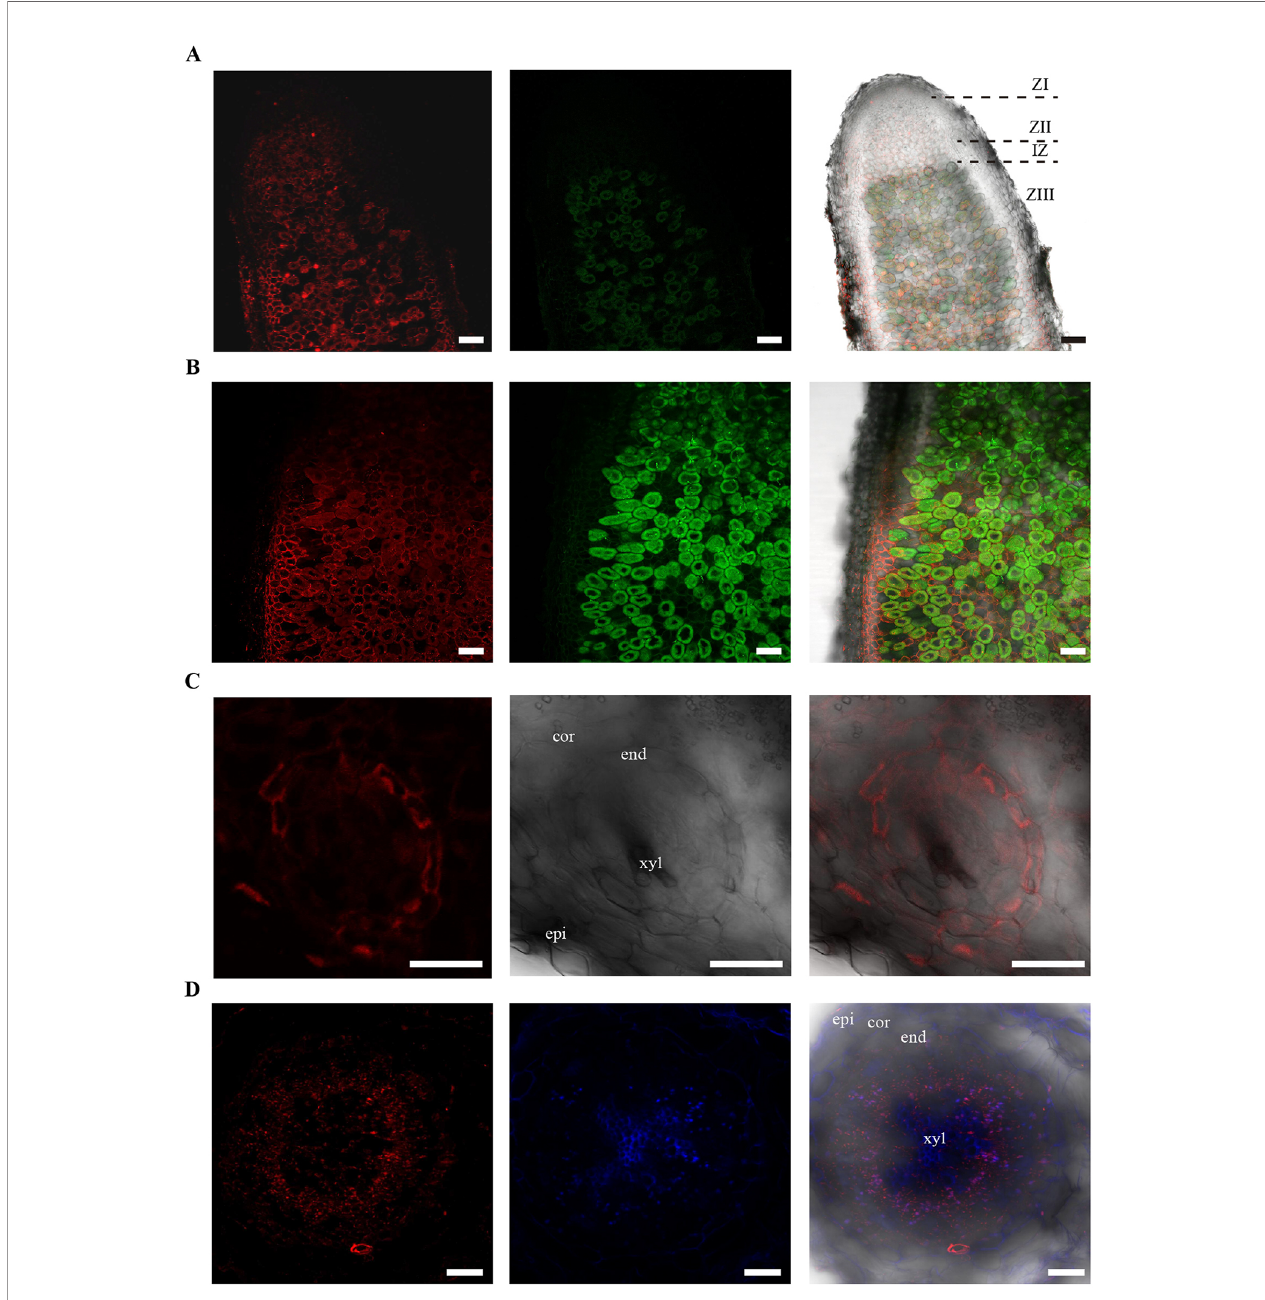
FIGURE 5 | MtNAS2 is located in the nodule core cells, in the endodermis of the nodule vessels, and in cells surrounding the xylem in the root vasculature. (A) Longitudinal section of a 28 dpi M. truncatula nodule expressing MtNAS2-HA under its own promoter (n = 30 sections from 10 to 20 plants). The three C- terminal HA epitopes were detected using an Alexa594-conjugated antibody (red, left panel). Transformed plants were inoculated with a GFP-expressing Sinorhizobium meliloti (green, middle panel). Both images were overlaid with the transillumination image (right panel). ZI indicates zone I; ZII, zone II; IZ, interzone; and ZIII, zone III. Bars = 100 m m. (B) Detail of the zone III of a 28 dpi M. truncatula nodule expressing MtNAS2-HA under its own promoter. Left panel corresponds to the Alexa594 signal used to detect the HA-tag, middle panel corresponds to the GFP channel showing S. meliloti , and the two were overlaid with the bright fi eld channel in the right panel (n = 30 sections from 10 to 20 plants). Bars = 50 m m (C) Cross section of a nodule vessel from a 28 dpi M. truncatula nodule expressing MtNAS2- HA under its own promoter. Left panel corresponds to the Alexa594 signal used to detect the HA-tag, middle panel corresponds to the bright fi eld channel, and the two were overlaid in the right panel (n = 30 sections from 10 to 20 plants). epi indicates nodule epidermis; cor, nodule cortex; end, nodule vascular endodermis; and xyl, nodule vascular xylem. Bars = 50 m m. (D) Cross section from a 28 dpi M. truncatula root expressing MtNAS2-HA under its own promoter. Left panel corresponds to the Alexa594 signal used to detect the HA-tag, middle panel corresponds to auto fl uorescence signal of xylem, and the two were overlaid with the bright fi eld channel in the right panel (n = 30 sections from 10 to 20 plants). epi indicates root epidermis; cor, root cortex; end, root endodermis; and xyl, xylem. Bars = 100 m